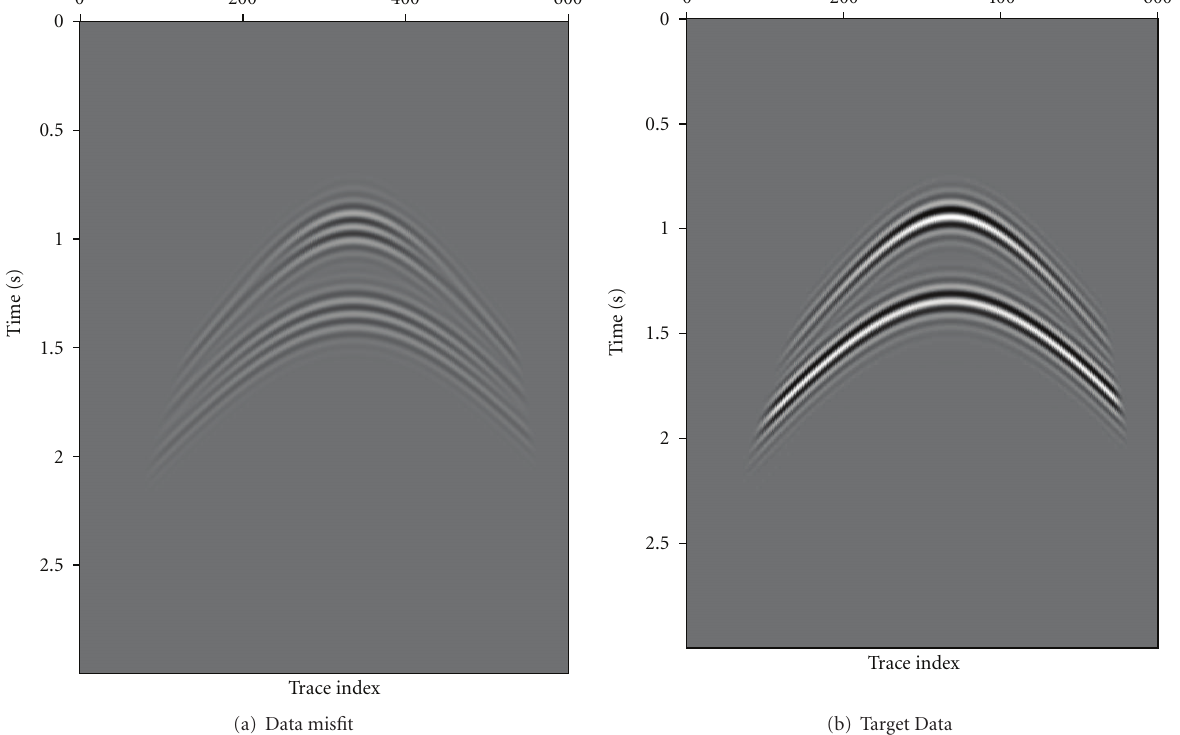
Figure 7: Data misfit versus target data. The inverted model fits 70% of the